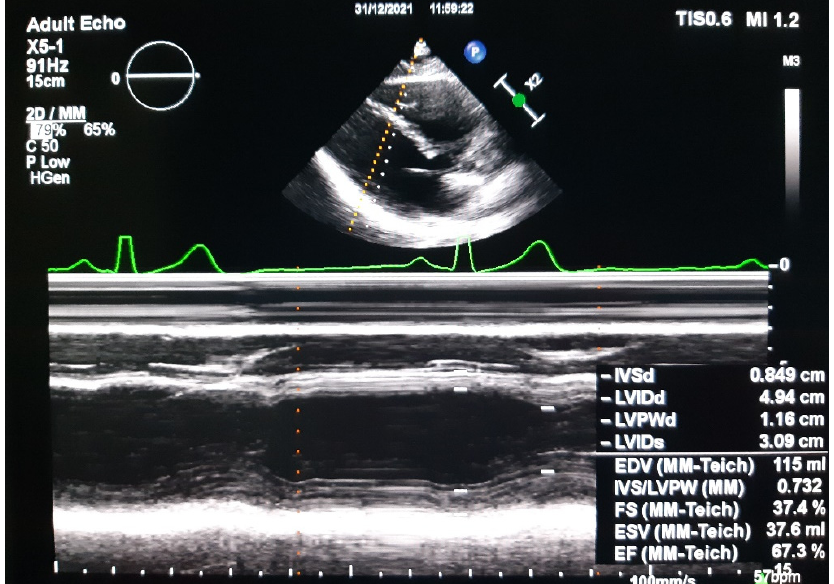
Figure 1. M-Mode echocardiography of a healthy pregnant patient, in parasternal long-axis view showing left ventricular fractional shortening and ejection fraction–IVSd (interventricular septum thickness at diastole, LVIDd (left ventricle internal diameter during diastole), LVIDs (left ventricular internal diameter during systole, LVPWd (left ventricular posterior wall thickness during diastole, EDV (end diastole volume), ESV (end systole volume), EF (ejection fraction), FS (fractional shortening). Courtesy of Elias Cardiology Department.